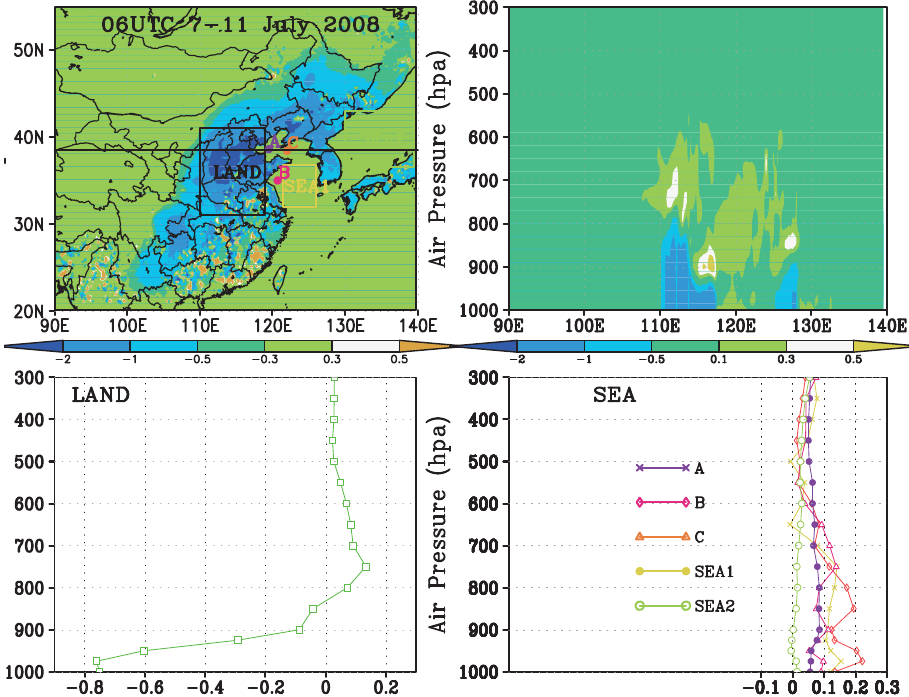
Figure 3. Mean temperature changes (K) at 06:00 UTC of 7–11 July due to aerosol DRF: (a) surface temperature; (b) vertical section at 38 ◦ N of (a) ; (c) vertical section of domain LAND region; (d) vertical section of points A, B, C, SEA1 and